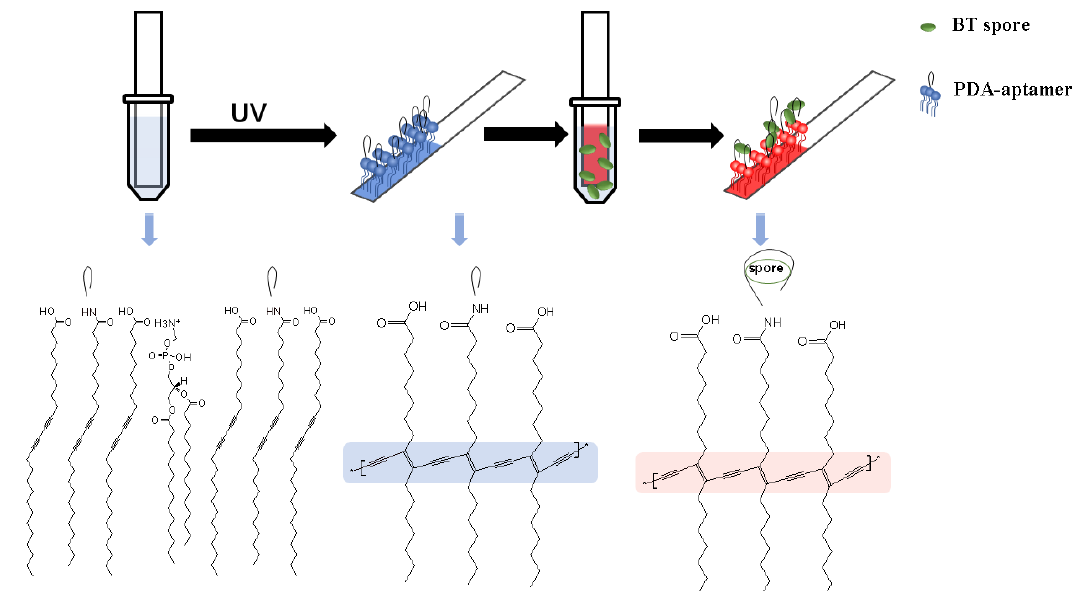
Figure 1. Schematic of the PDA-aptamer paper strip coating, the entire detection process and the key chemical structures. The immobilized PDA-aptamer was polymerized by UV exposure, and it turned blue. After a short incubation period, the BT spores were recognized by the PDA-aptamer, and the reaction between the aptamer and spore induced a color change in the PDA from blue to red.2. Materials and Methods.